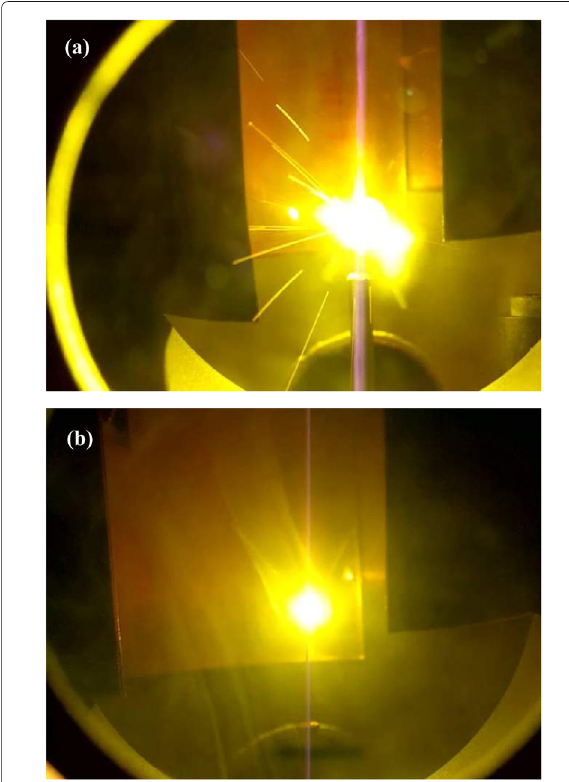
Fig. 2 Video frames (30 frames s − 1 and 1/60 s for exposure) of the scenes in the experiments for a run# 84 and b run# 32. The molten sample (MLB) sits in the center of the bright halo, and the laser beam comes from the 10 o’clock direction. a A dozen droplets, seen as bright and straight rays, are radially ejected from the MLB almost simultaneously. (One droplet is actually seen at the tip of the ray in the 10 o’clock position). b A smoke composed of condensed particles rises from the evaporating MLB, while clusters of previously condensed particles form sheet-like structures in the convective motions of the ambient gas. This scene was taken within a fraction of second after the laser power was shut off, when the MLB temperature dropped below the boiling point